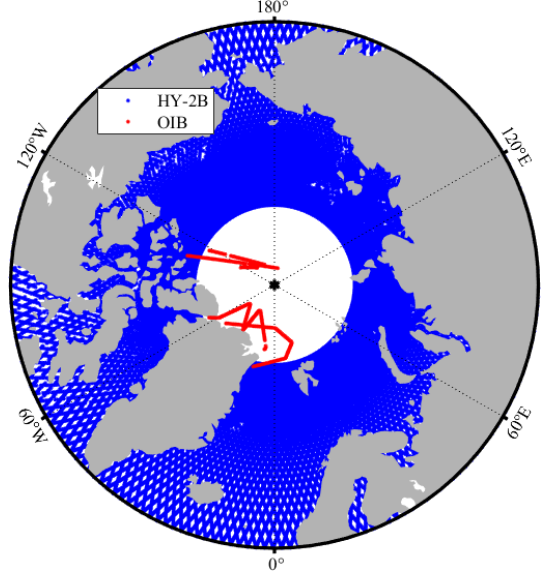
Figure 1. Ground tracks of the HY-2B SGDR product (blue points) and flight tracks of Operation IceBridge (OIB) airborne experiments (red points) across the Arctic in April